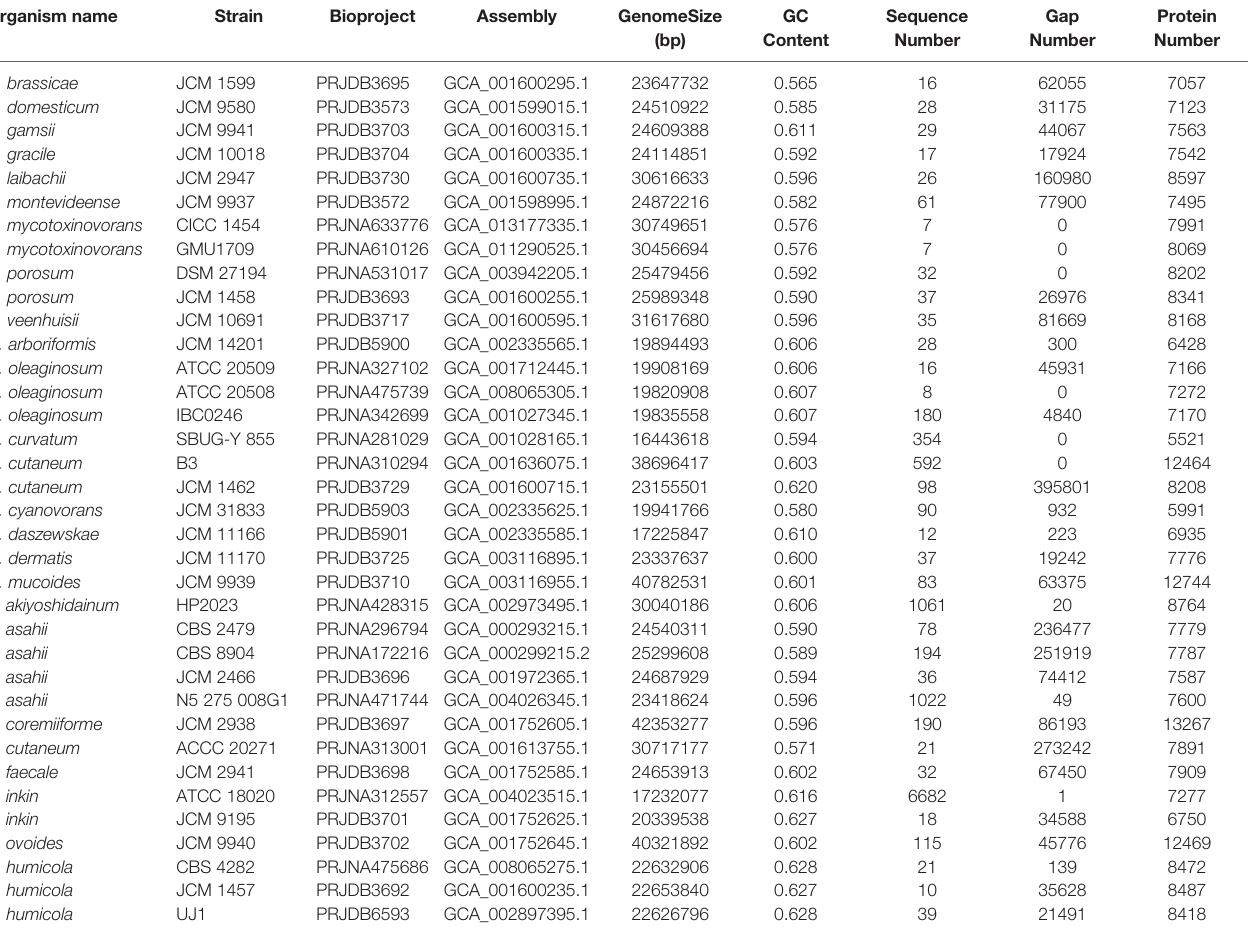
TABLE 1 | Thirty-six strains from four genera and 25 species of the Trichosporonaceae